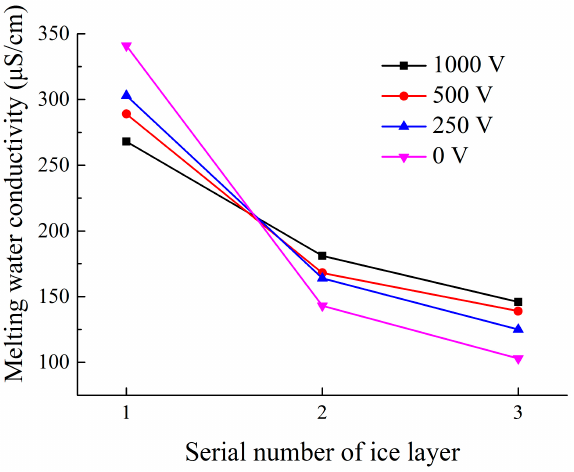
Figure 4. Melting water conductivity under different applied alternating voltage condition.